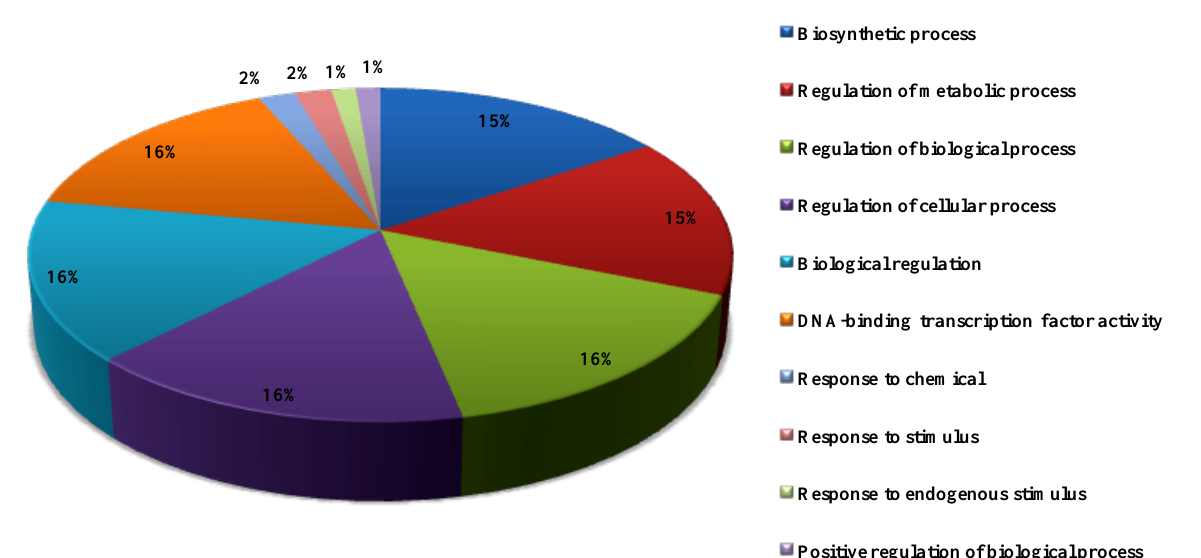
Figure 6. OsWRKY genes and their biological functions . The biological function was imputed according to the significance level ( p -value FDR cutoff).